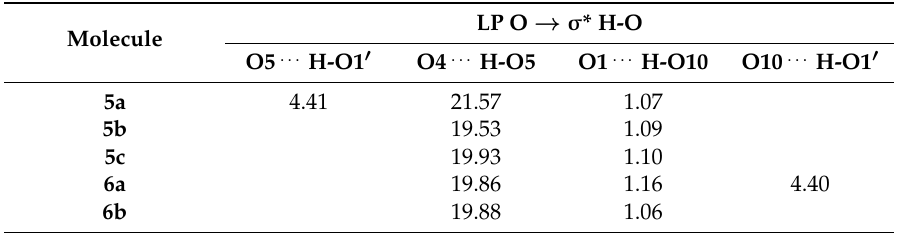
Table 13. Stabilization energies (kcal/mol) for selected NBO pairs (donor-acceptor) given by second-order perturbation energies for 5 and 6